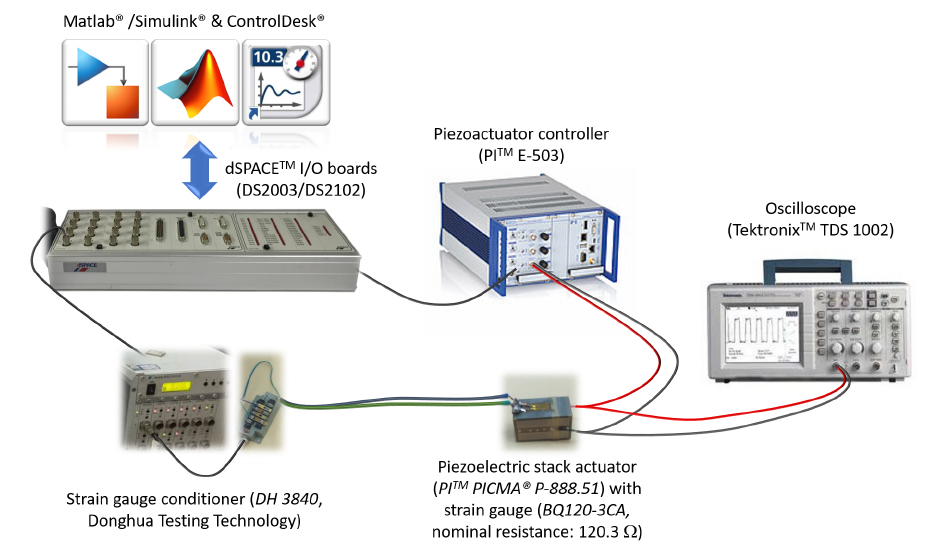
Figure 6. Experimental